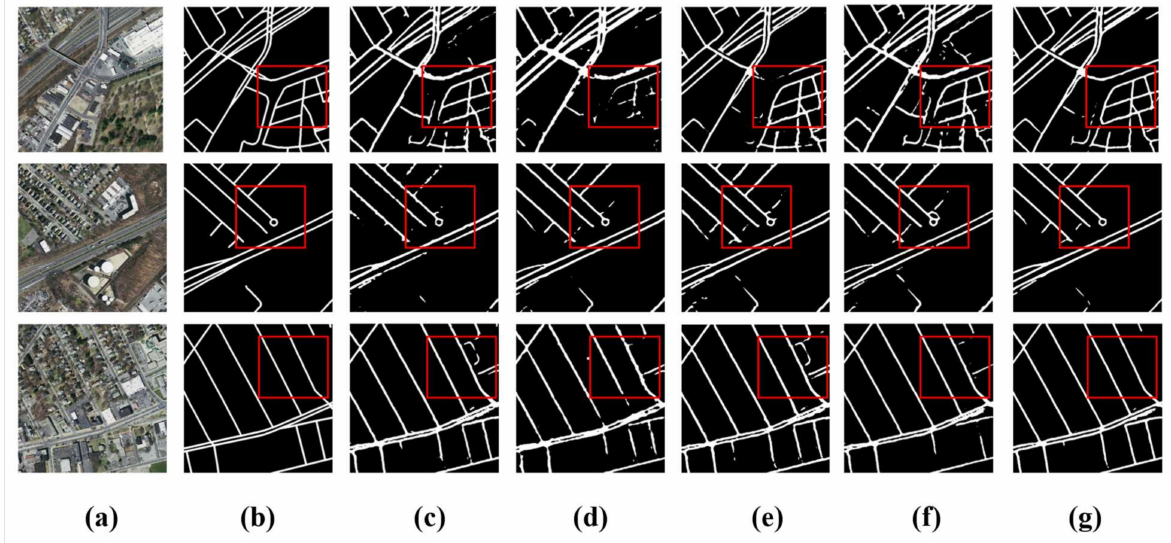
Figure 8. More examples of segmentation results. ( a ) The test image. ( b ) The ground truth. ( c ) Results with DeepLabV3+. ( d ) Results with D-LinkNet. ( e ) Results with D-ResUnet. ( f ) Results with DCS- TransUperNet. ( g ) Results with